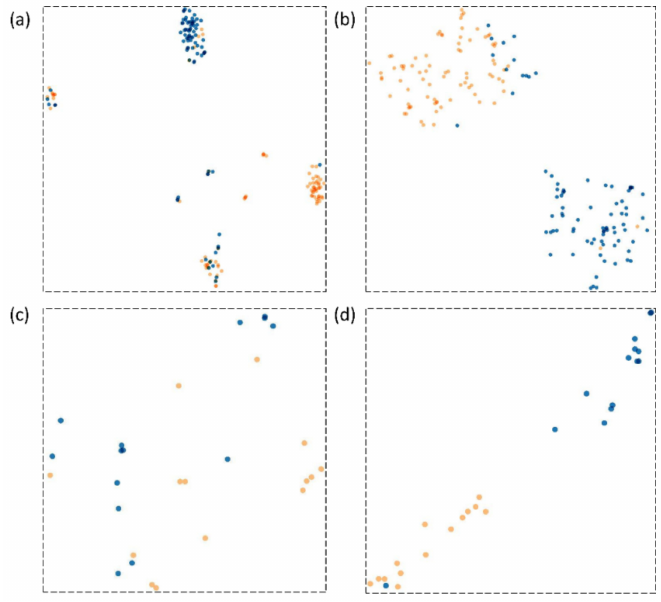
Figure 14. Feature embedding visualization with the t-SNE algorithm. The blue-colored points denote the feature embeddings for the TB class and the orange-colored points denote that of the normal class. ( a ) t-SNE visualization obtained by the best-performing baseline model evaluated using the Shenzhen TB CXR collection; ( b ) t-SNE visualization obtained by the best-performing bone-suppressed model evaluated using the Shenzhen TB CXR collection; ( c ) t-SNE visualization obtained by the best-performing baseline model evaluated using the Montgomery TB CXR collection, and ( d ) t-SNE visualization obtained by the best-performing bone-suppressed model evaluated using the Montgomery TB CXR